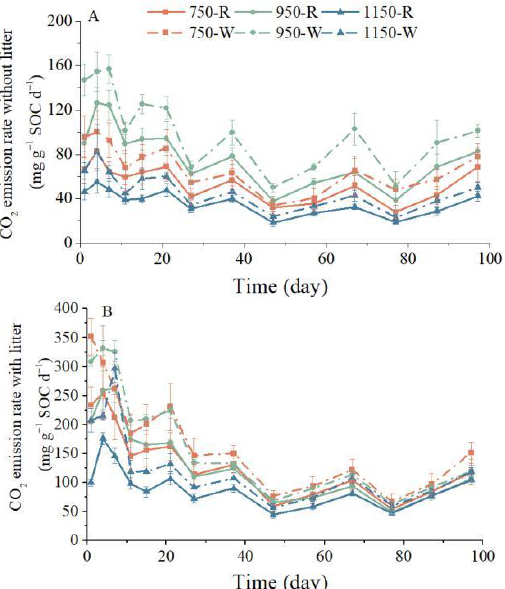
Figure 1. Dynamics of CO 2 efflux rate from control (A) and litter-mended soils (B) along the different elevations (750, 950, 1150 m) during the 97 day incubation period. R and W represent room temperature and warming temperature, respectively. The vertical bars are standard errors.